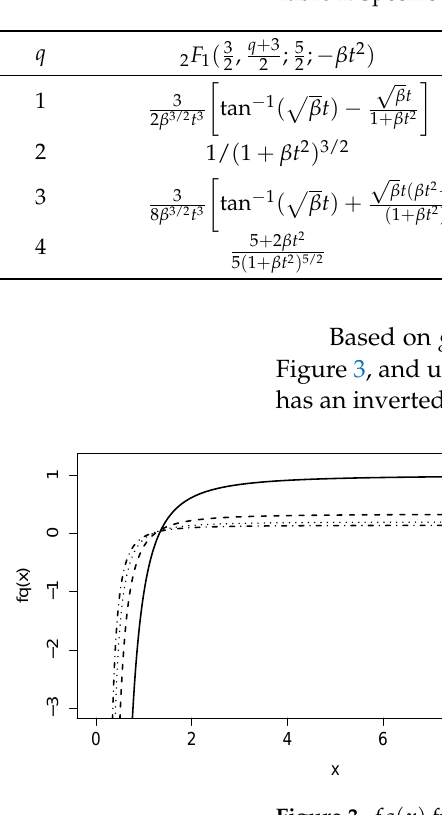
Table 1. Specific values of 2 F 1 ( 3